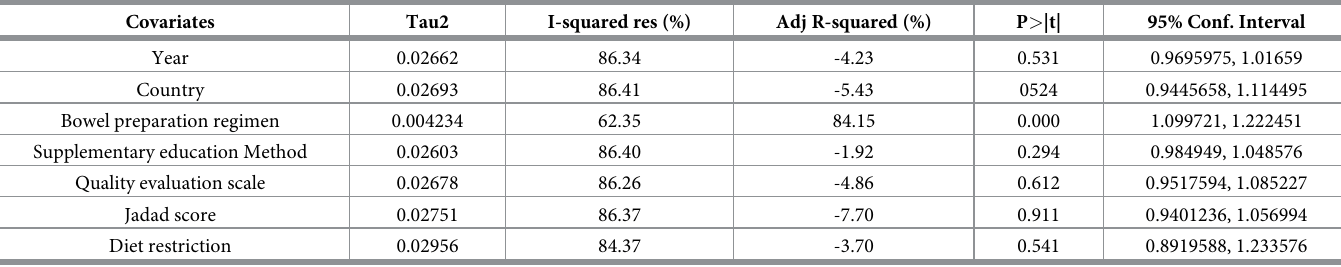
Table 3. Meta-regression analysis